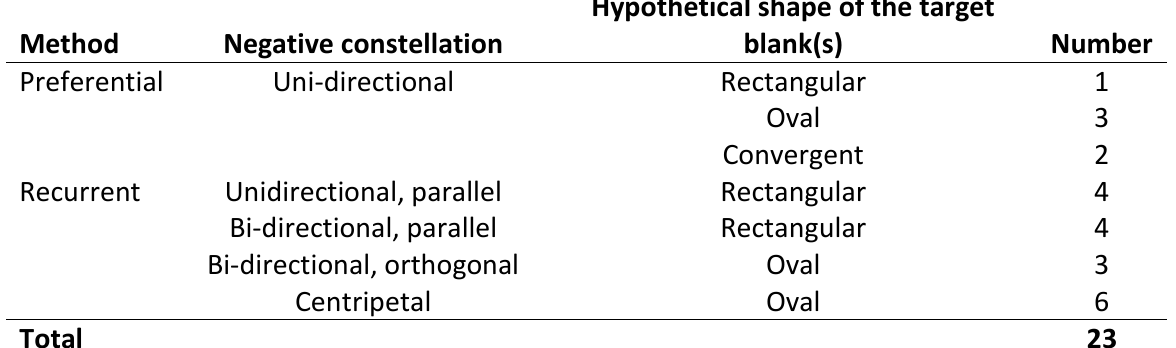
Table 8. Method, negative constellation and hypothetical shape of target blank(s) on Levallois cores from GH 3.